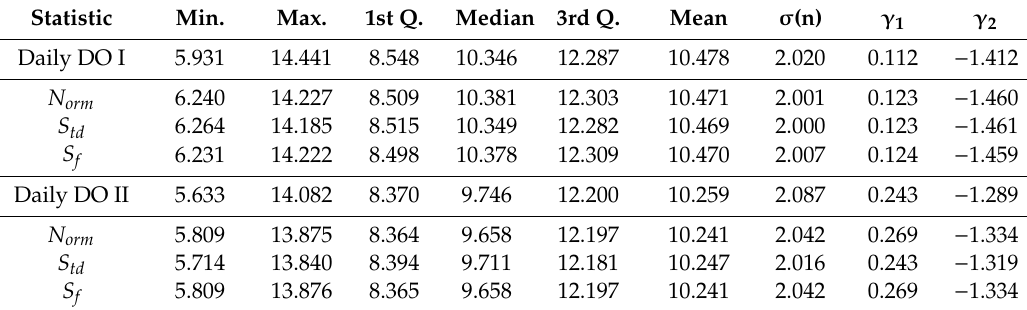
Table 5. Descriptive statistics of the forecasted DO data vs. the observations.